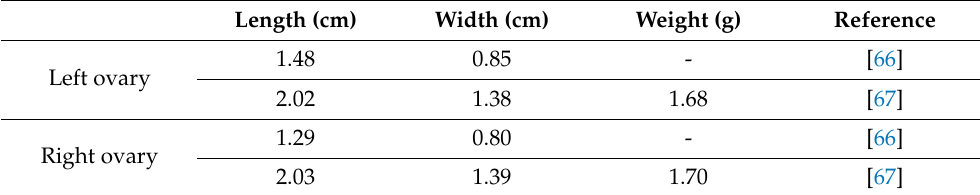
Table 6. Average morphometric data of the pacas’ ovaries. Length (cm) Width (cm) Weight (g) Reference 1.48 0.85 - [66] Left ovary 2.02 1.38 1.68 [67] 1.29 0.80 Right ovary